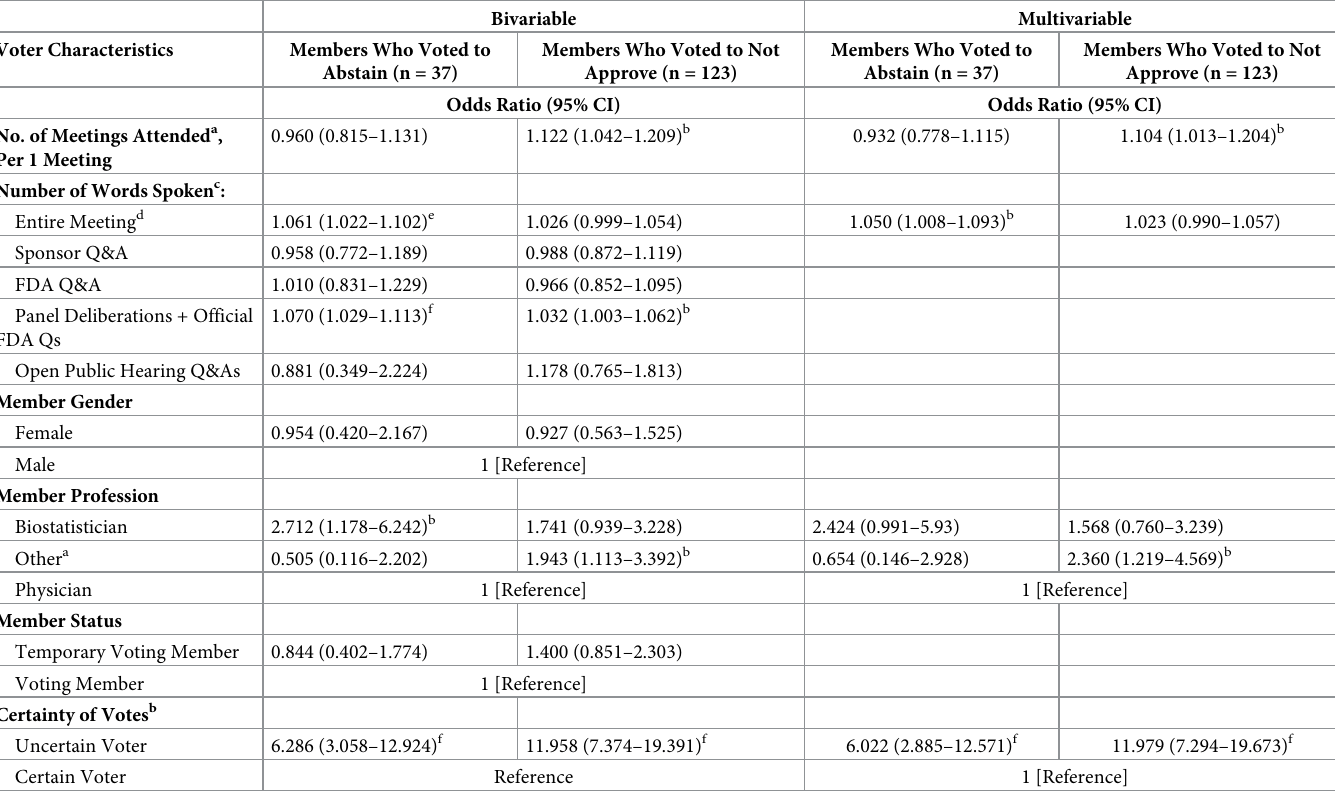
Table 3. Bivariable and multivariable multinomial logistic regression for factors associated with voting to abstain or voting “not in favor” during the final device approval recommendation